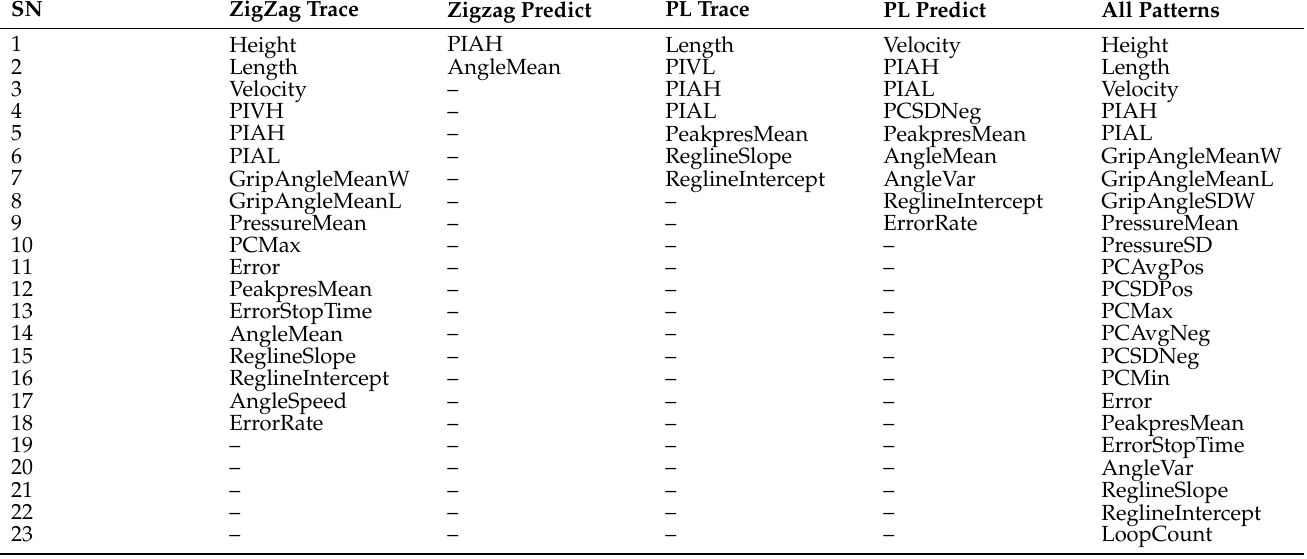
Figure 5. Identification of common features from SFFS-RF and SFFS-SVM for different lines of handwritten pattern dataset: ( a ) Feature from trace of zigzag line, ( b ) feature from the prediction of zigzag line, ( c ) feature from trace of PL line, ( d ) feature from prediction of PL line, and ( e ) feature from all handwritten patterns. Table 9. List of common features of handwritten pattern